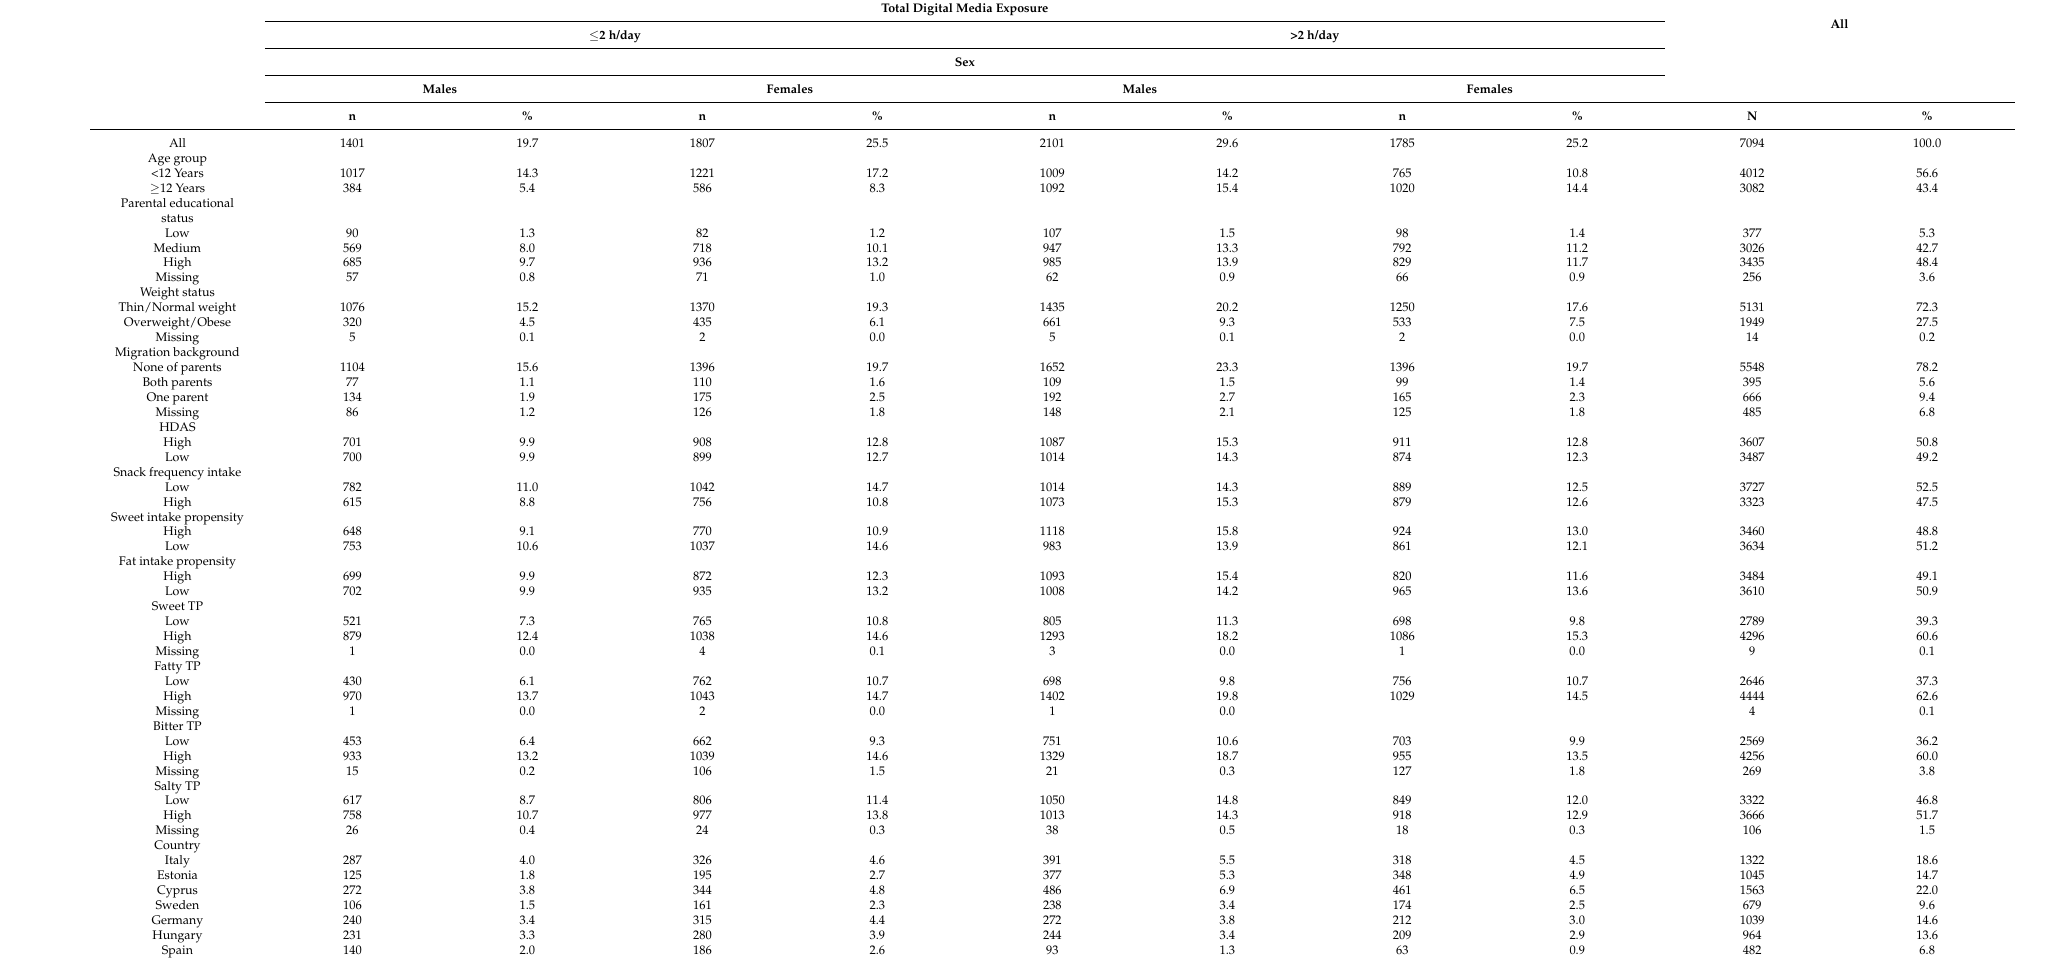
Table 1. Characteristics of the study population by sex and exposure to digital media 1